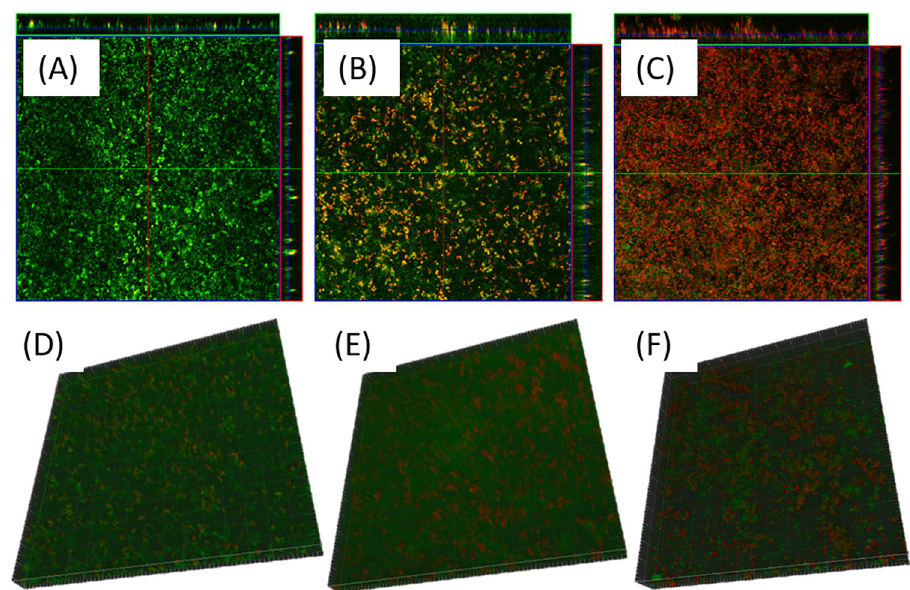
Fig 6. CLSM images of 3-day P . gingivalis biofilms. 2D images of: A) Untreated control, B) 1-min argon+1% oxygen plasma treatment, C) 5-min argon+1% oxygen plasma treatment; 3D images of: D) Untreated control, E) 1-min argon +1% oxygen plasma treatment, F) 5-min argon+1% oxygen plasma